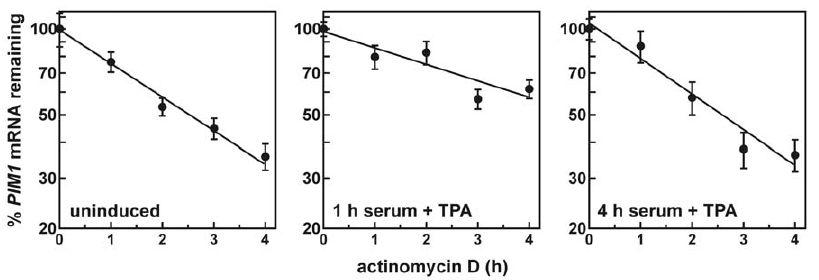
Figure 2. Control of PIM1 mRNA turnover in mitogen-stimulated HeLa cells. The decay kinetics of PIM1 mRNA were measured in serum- starved HeLa cells (uninduced) or at selected times after stimulation with serum + TPA using actD time course assays. For each experiment, the fraction of PIM1 mRNA remaining was plotted as a function of time following inhibition of transcription by actD, and PIM1 mRNA decay constants resolved by nonlinear regression to a first-order decay model ( lines ). Average decay constants measured across replicate independent experiments are listed in Table 1.